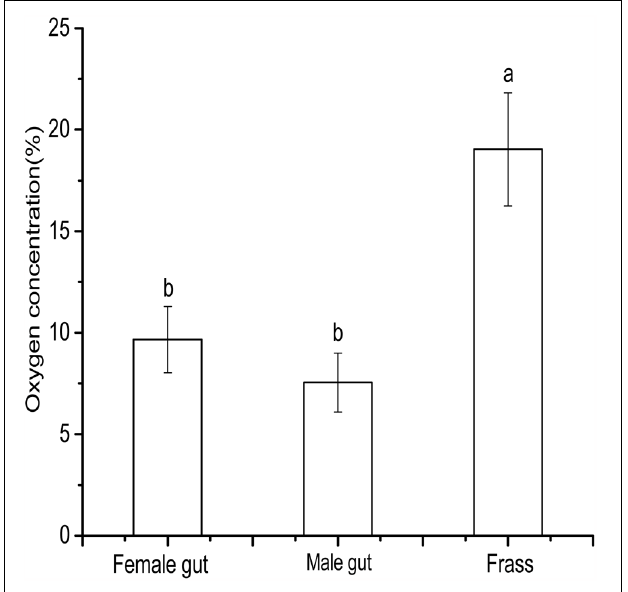
FIGURE 4 | Oxygen concentrations of Dendroctonus valens gut and frass. The bars with different letters are significantly different at P = 0.05.